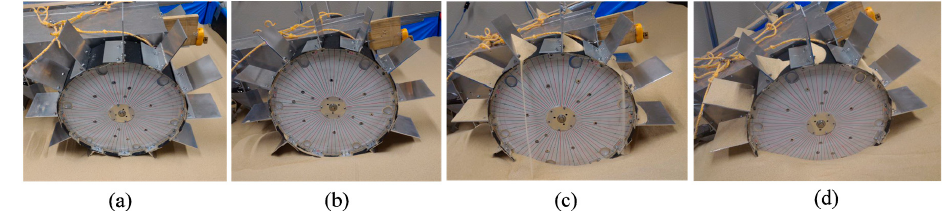
Figure 11. Best performances for conventional wheels with grouser length 80 mm: ( a ) Level incline; ( b ) 10 degree incline; ( c ) 20 degree incline; ( d ) 30 degree incline. ( b ) 10 degree incline; ( c ) 20 degree incline; ( d ) 30 degree